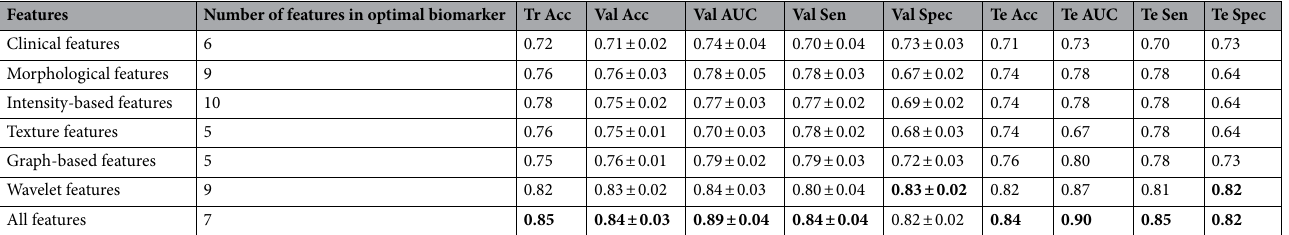
Table 2. Results of NAC response prediction at pre-treatment using the clinicopathological and/or pathomic features, on the training, validation and test sets. The features included in each optimal biomarker have been listed in Fig. 2. For the validation set, the 95% confidence intervals are reported over the five folds of cross validation. The best value in each column is in bold. Acc accuracy, AUC area under the curve, Sen sensitivity, Spec specificity, Tr training, Val validation, Te test.